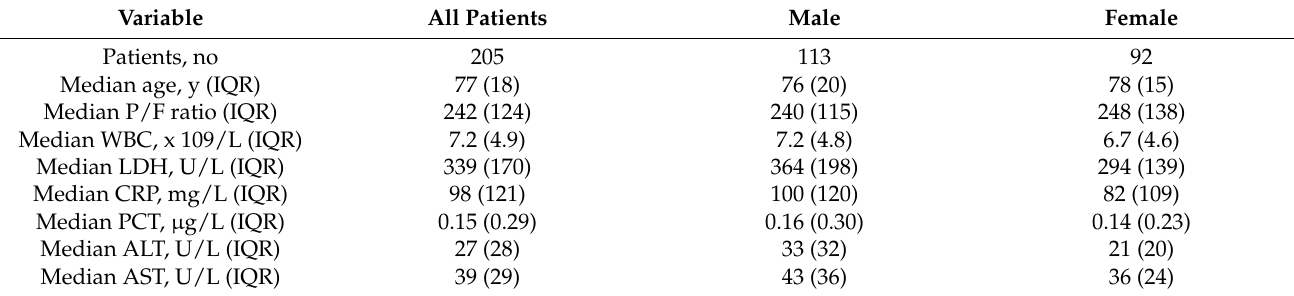
Table 1. Clinical characteristics at presentation of patients with SARS-CoV-2